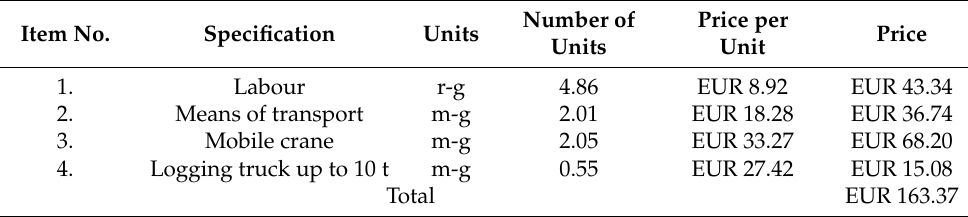
Table 6. Material expenditure for dismantling a reinforced concrete pole per pole, taking into account the nature of the planned works.